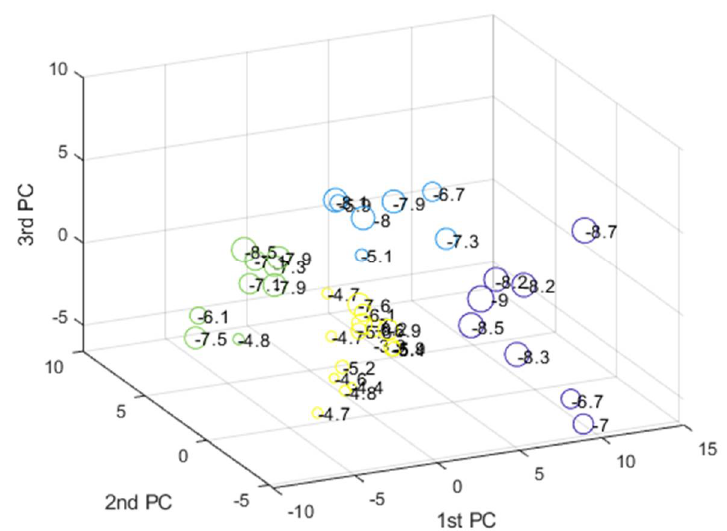
Figure 17. The PCA 3D score plot labeled with corresponding docking score values. Member of each cluster found by K-means clustering are depicted with different colors.